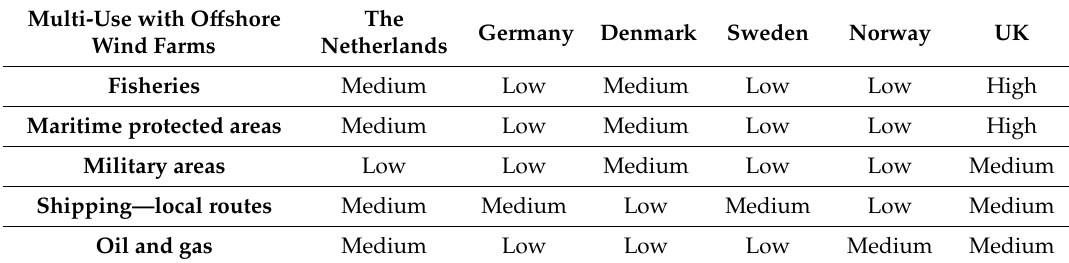
Table 5. Potential for multi-use between o ff shore wind farms and other marine uses / per country. Multi-Use with O ff shore The Germany Denmark Sweden Norway UK Wind Farms Netherlands Fisheries Medium Low Medium Low Low High Maritime protected areas Medium Low Medium Low Low High Military areas Low Low Medium Low Low Medium Medium Medium Low Medium Low Medium Oil and gas Medium Low Low Low Medium